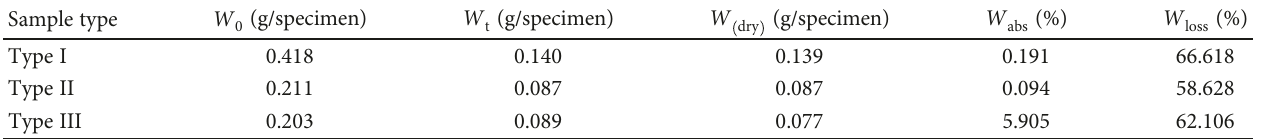
Table 3: Water absorption (%) and weight loss (%) with respect to soil burial